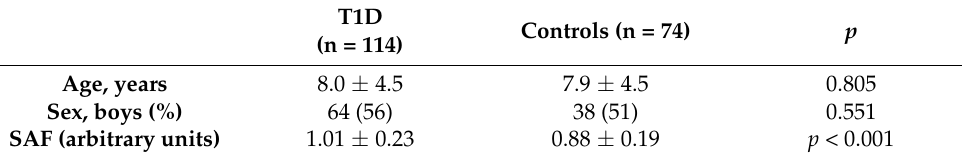
Table 3. Skin autofluorescence at the time of diagnosis in both groups.